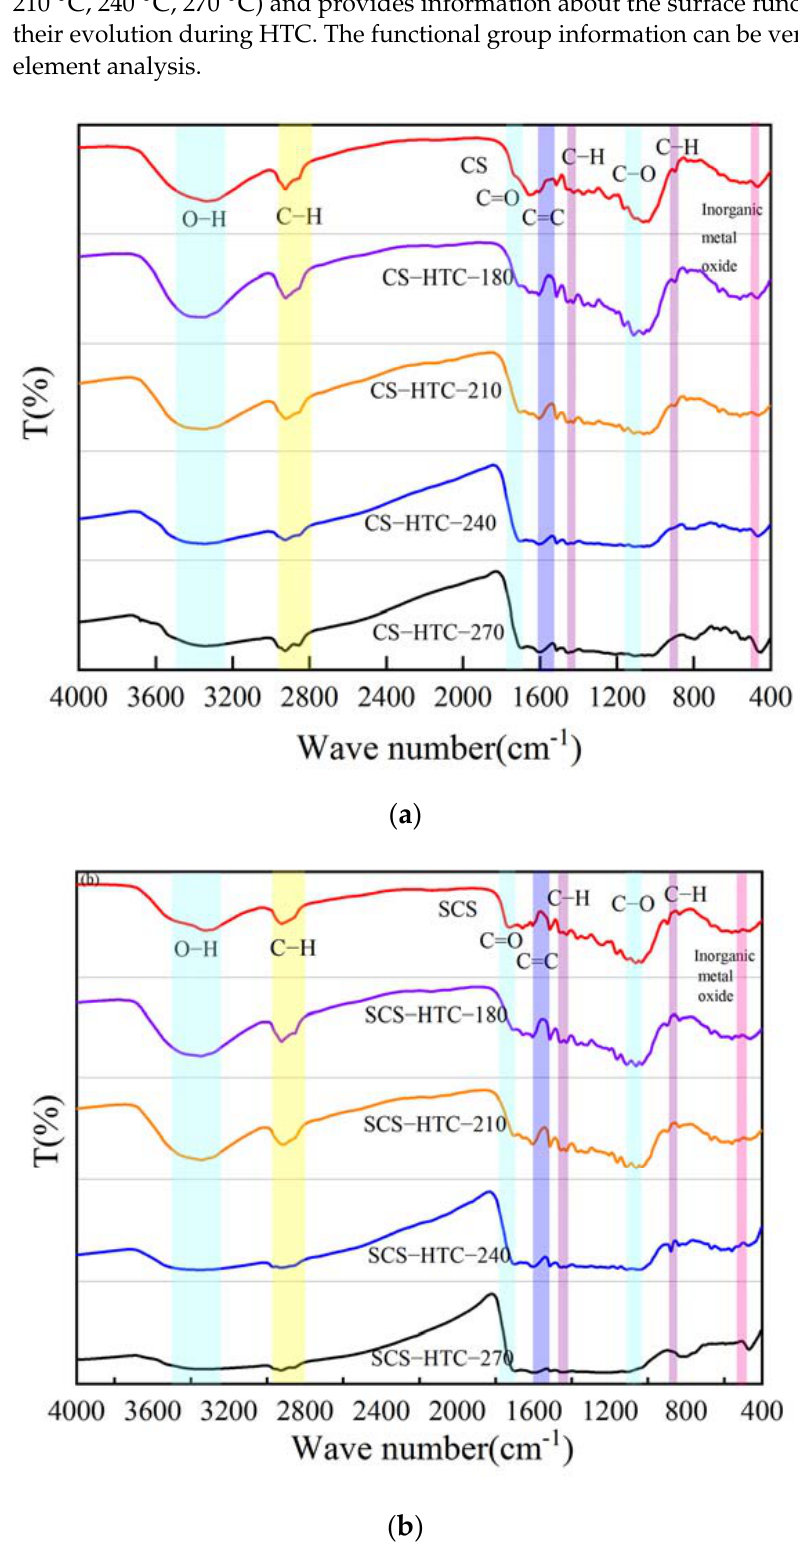
Figure 4. FTIR of CS, SCS and their hydrochar, ( a ) CS and ( b ) SCS.